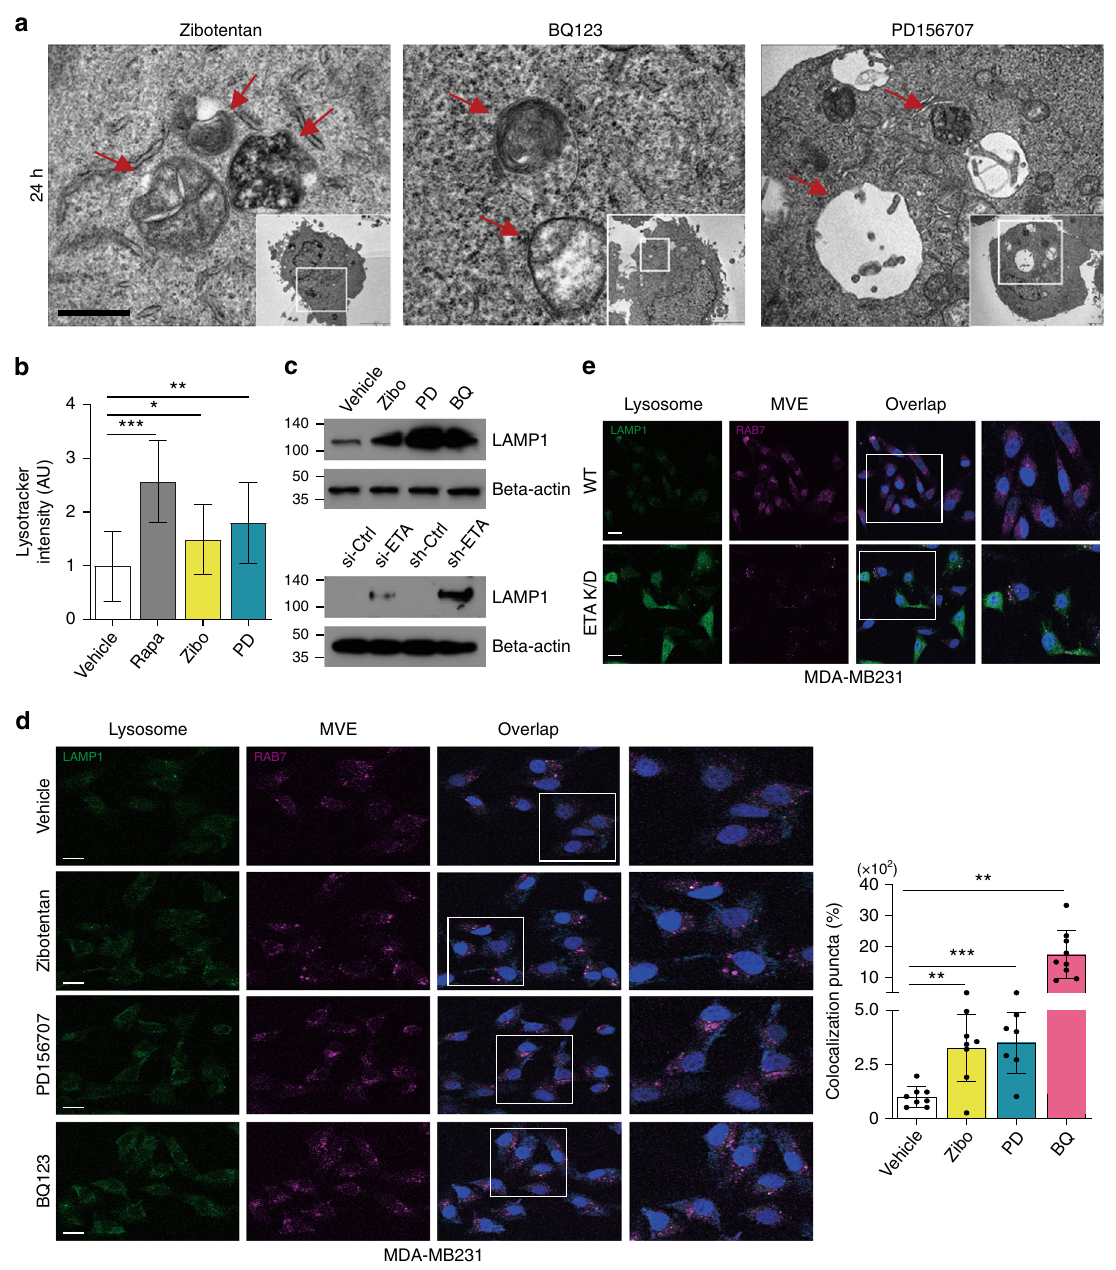
Fig. 7 Antagonists against the endothelin receptor induce fusion of MVEs with lysosomes in MDA-MB231 cells. a TEM analysis of ETA-antagonist-treated MDA-MB231 cells. Scale bar, 5 μ m. b Measurement of lysotracker (red) intensity in rapamycin-treated or antagonist (Zibotentan and PD156707)-treated MDA-MB231. Lysotracker intensity measurement >100 cells per group. c Top, Immunoblot of LAMP-1 protein in antagonist (Zibo, BQ-123, and PD156707)-treated MDA-MB231. Bottom, Immunoblot of LAMP-1 protein in ETA-siRNA-transfected MDA-MB231 and in ETA-K/D MDA-MB231. n = 3. d Left, Image of MDA-MB231 treated by SFX. Green, CellLight-Lysosome-GFP (GFP-LAMP1). Red, CellLight-late endosome/MVE-RFP (RFP-RAB7). Scale bar, 2 μ m. Right, Quantitative colocalization rates of lysosomes and MVE in MDA-MB231 treated with Zibotentan, PD156707, or BQ123. Colocalization puncta count >65 cells per group. e Images of ETA K/D MDA-MB231 or WT MDA-MB231 cells. Different colors represent the same markers as described in d . Scale bar, 2 μ m. Experiments were performed with 95% con fl uent cells. Signi fi cance was determined using an unpaired two-tailed Student ’ s t